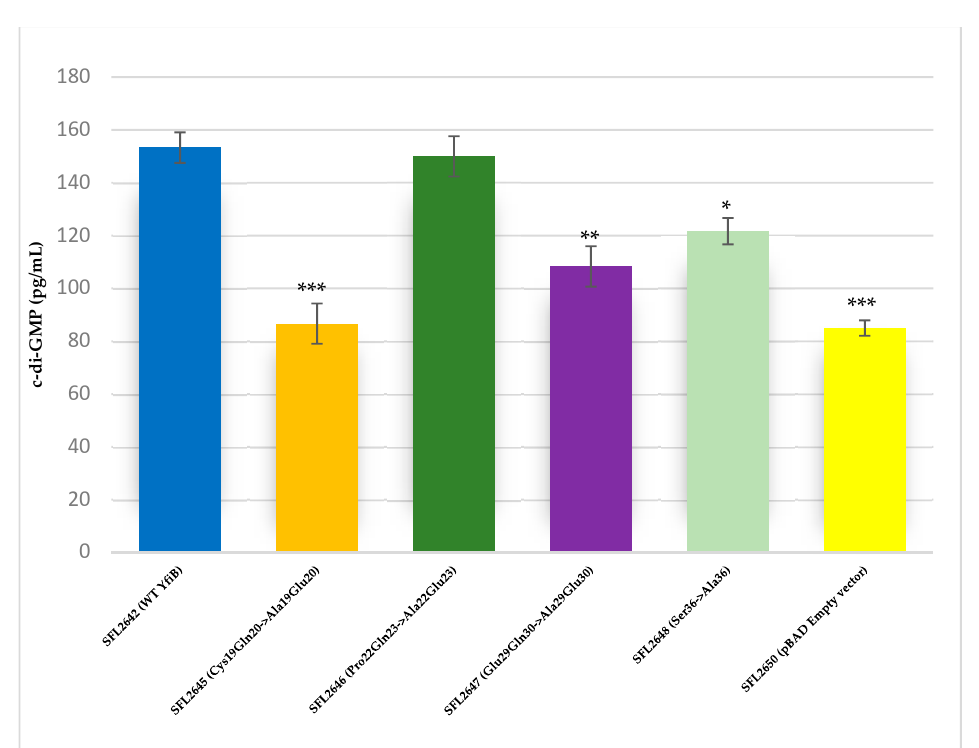
Figure 8. Quantification of intracellular c-di-GMP levels. Bar graph showing the levels of native c-di-GMP for S. flexneri strains containing WT YfiB (SFL2642), the YfiB site-directed mutants: SFL2645 (Cys19Gln20->Ala19Glu20), SFL2647 (Glu29Gln30->Ala29Glu30), SFL2646 (Pro22Gln23- >Ala22Glu23), SFL2648 (Ser36->Ala36), and the empty pBAD vector used as negative control (SFL2650). The c-di-GMP concentration was analysed using a Cyclic-di-GMP ELISA kit by Cayman Chemicals. The calculations are based on standard curve for c-di-GMP and assaying each sample in duplicates. Statistically significant variance is denoted by asterisks (*** = p value < 0.001, ** = p value < 0.01, * = p value < 0.05). The standard deviation of data from three autonomous experiments is depicted by the error bars.